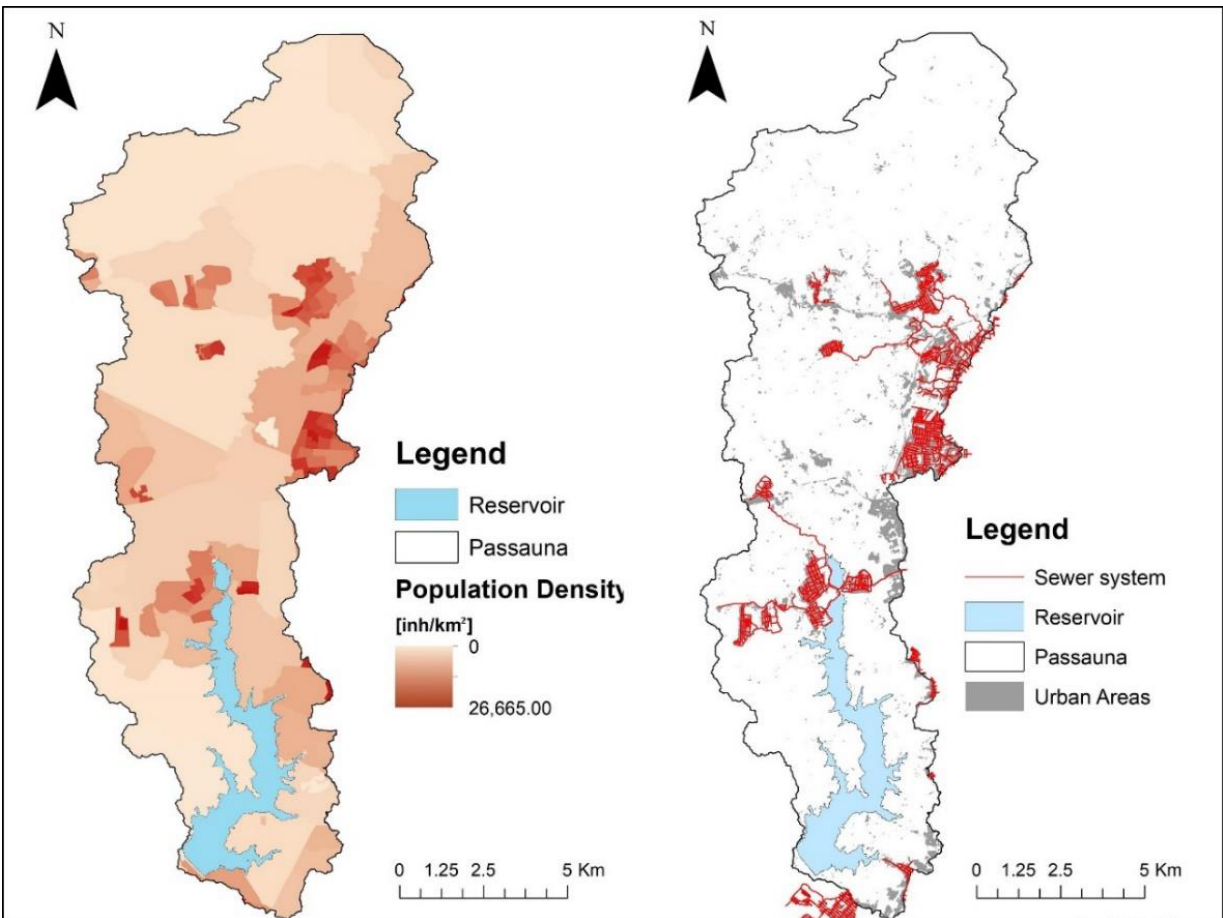
Figure 2. Population density [17] ( left ) and sewer system ( right ) in the Passaúna catchment.